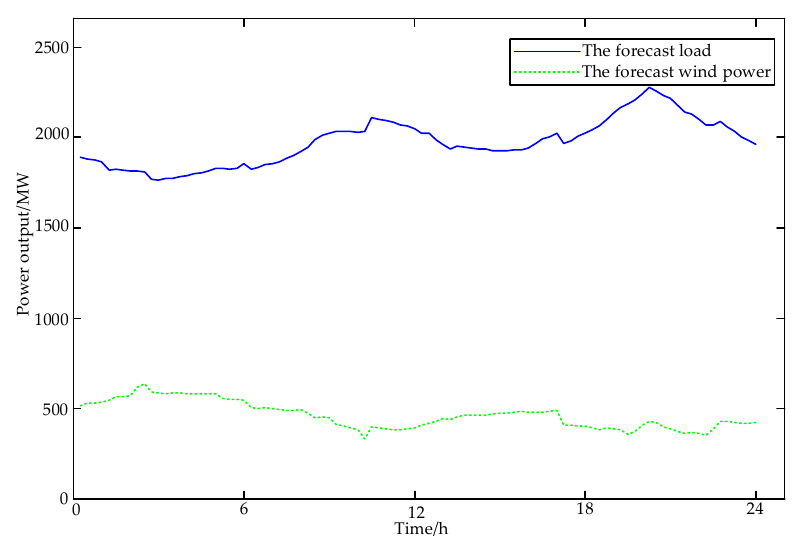
Figure 4. The forecast values of load and wind power. Energies 2018 , 11 , x